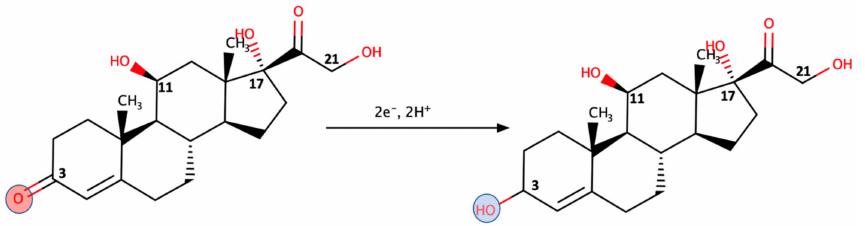
Figure 4. Cortisol reduction is preferable at the C3 carbonyl position of cortisol. Reproduced from [35] under CC BY-NC